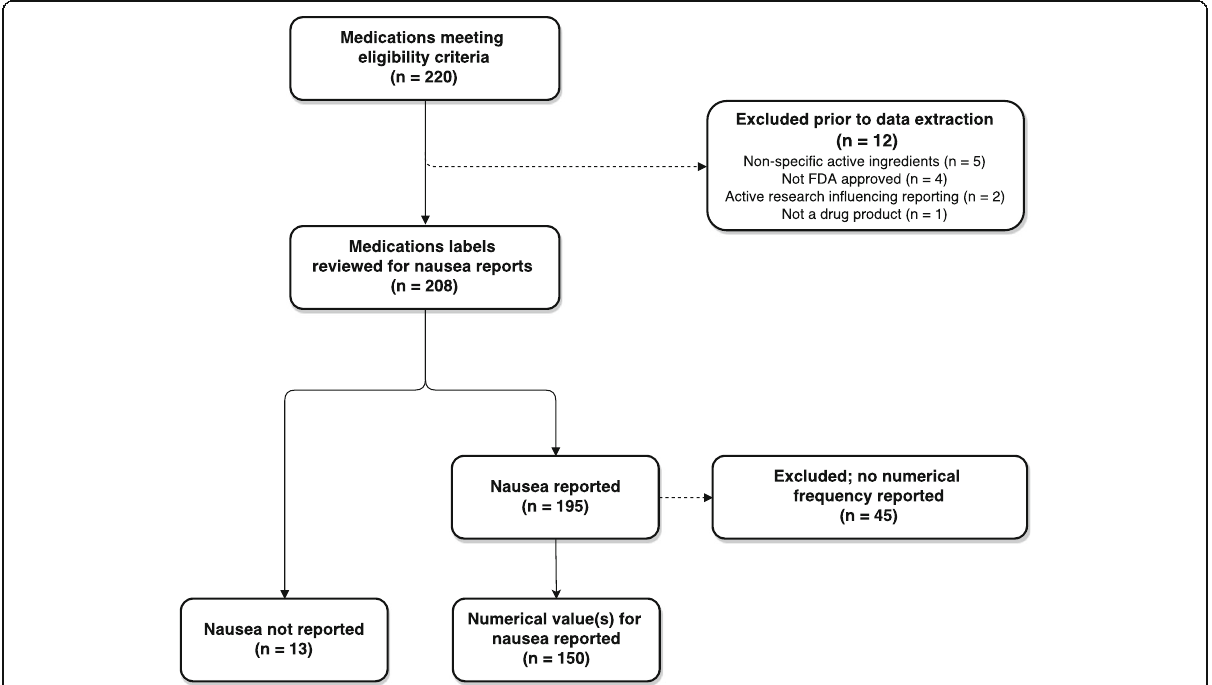
Fig. 1 Aggregation of available data by generic ingredient. A total of 163 medication met all of the inclusion criteria